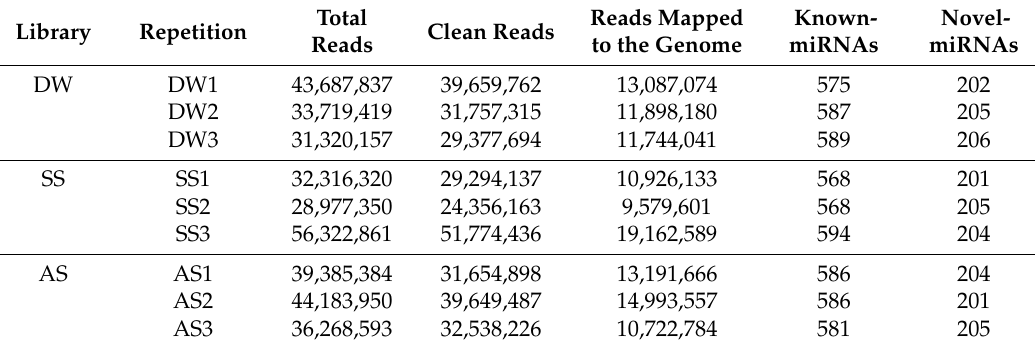
Table 1. Overview of small RNA sequences in nine R108